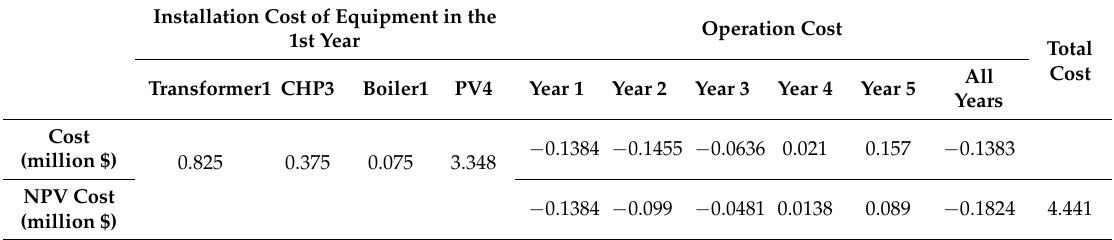
Table 5. Total cost with and without considering the net present value over the planning horizon.